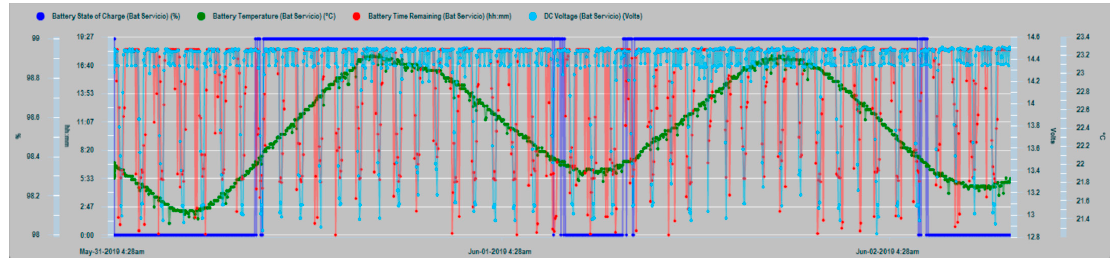
Figure 13. Data series of house battery bank parameters: State of Charge SOC (dark blue), Time Remaining TR (green), DC current (red), and DC Voltage (clear blue).